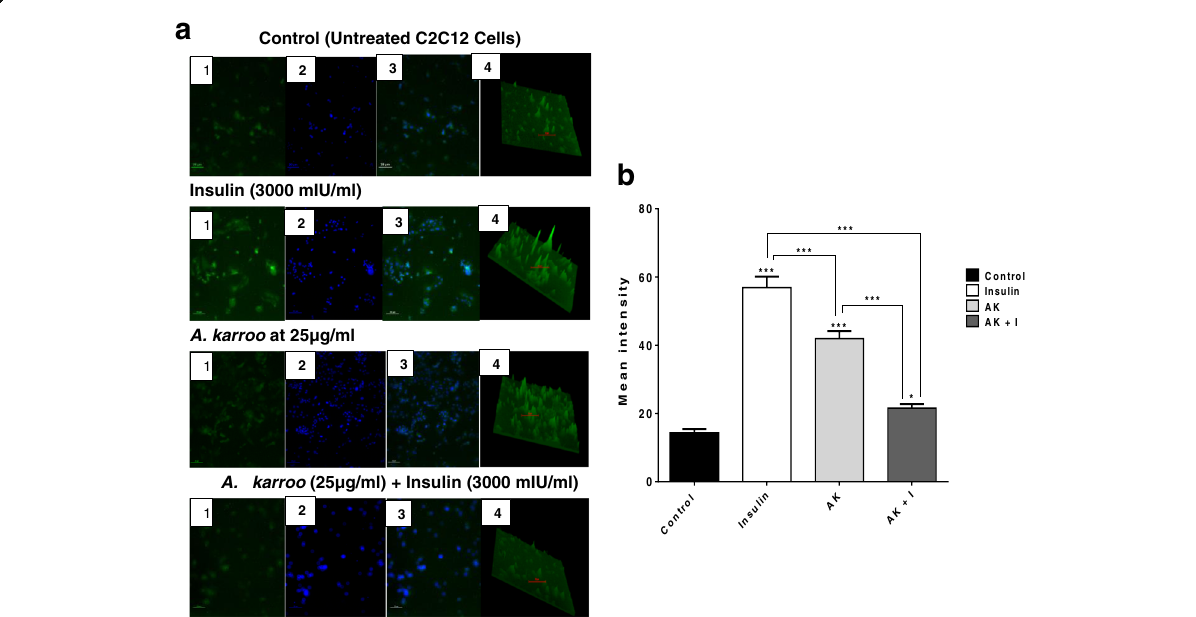
Fig. 2 Fluorescence intensity ( a ) and mean intensity ( b ) following 3 h of treatment with insulin (positive control), A. karroo (AK) and insulin + A. karroo (AK + I) and untreated C2C12 cells (standard control). a 1 = green fluorescence represent FITC bound GLUT4 molecules, 2 = blue represent Wuchi stained nucleus, 3 = Overlay of images 1 and 2 and 4 = intensity surface plot. All the images were taken at a magnification of 40X. b The results obtained were expressed as means ± SEM. The statistical significance of the results was tested using one way ANOVA, employing the Tukey-Kramer multiple comparisons test. The P value significance was represented by an asterisk (*) for P < 0.05, two asterisks (**) for P < 0.01 and three asterisks (***) for P <